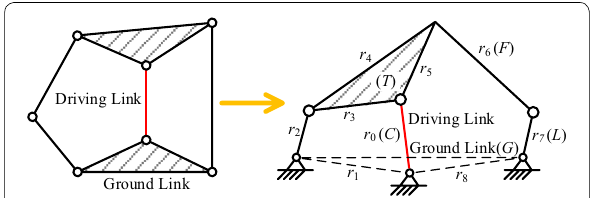
Figure 1 Closed-chain leg